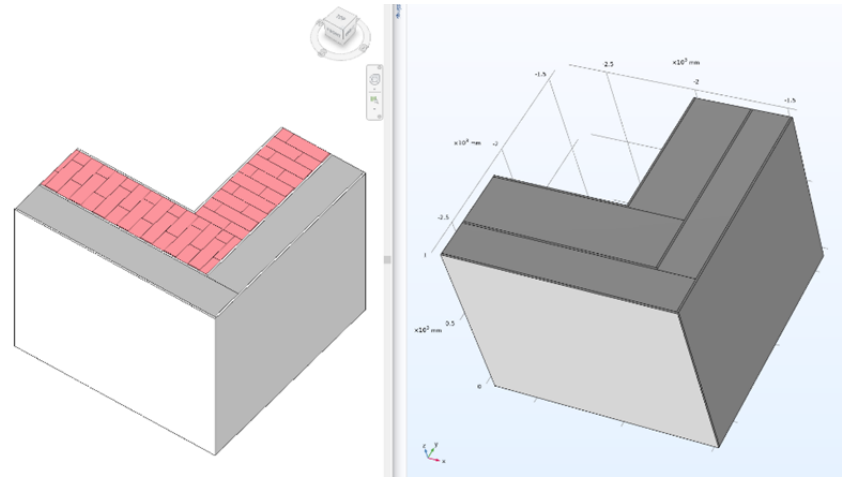
Figure 3. The model from Revit 2021 (left) imported to Comsol 5.6 (right).